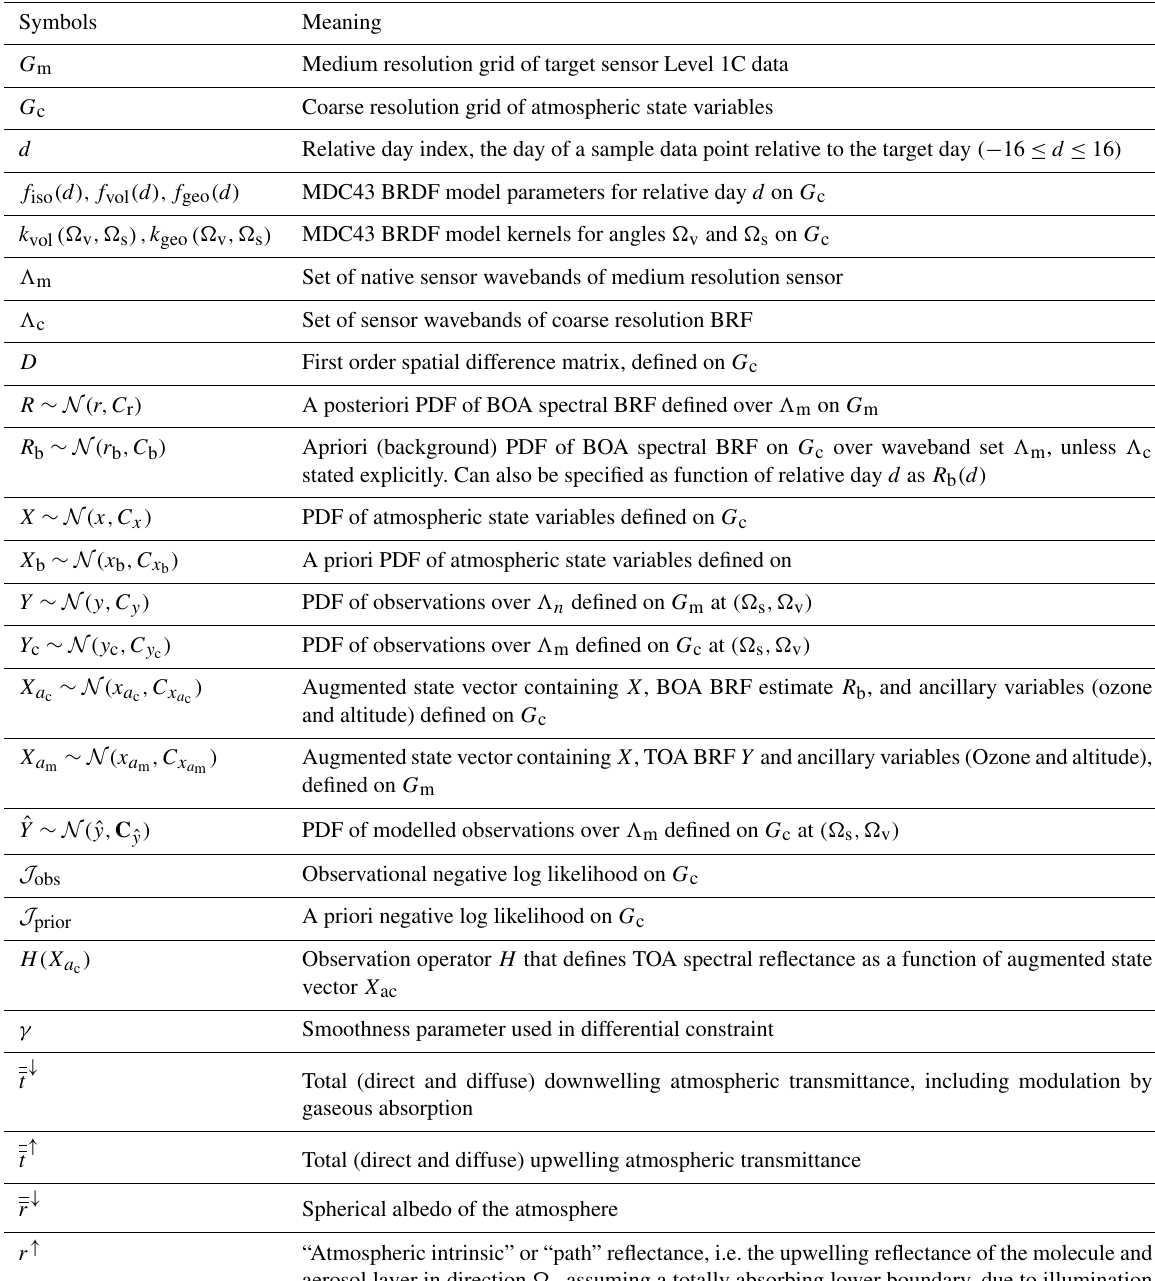
Table 2. Main symbols used in the paper. C ∗ represents the covariance matrix part of the PDF for parameter ∗ . Symbols Meaning G